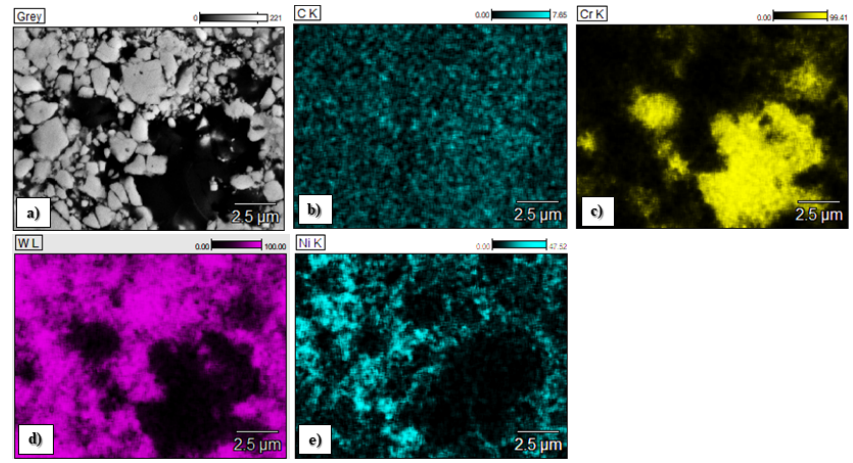
Figure 6. Elemental distribution maps of spraying elements in the analyzed area of the C2 coating obtained during thermal spraying: ( a )—central part of the layer, ( b )—map of the carbon, ( c )—map of the cobalt, ( d )—map of the tungsten.